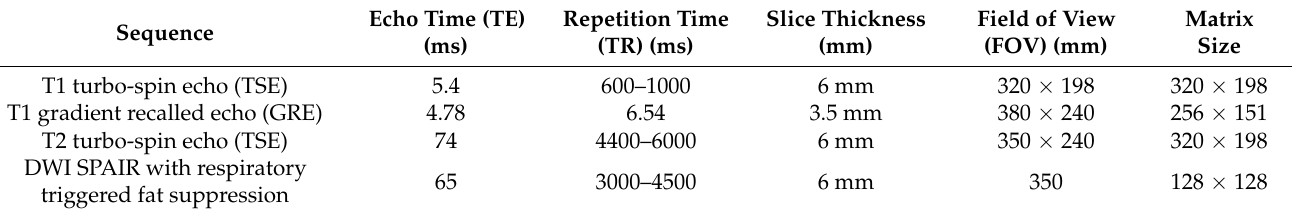
Table 2. Imaging parameters used for the study on a 1.5 T magnetic resonance